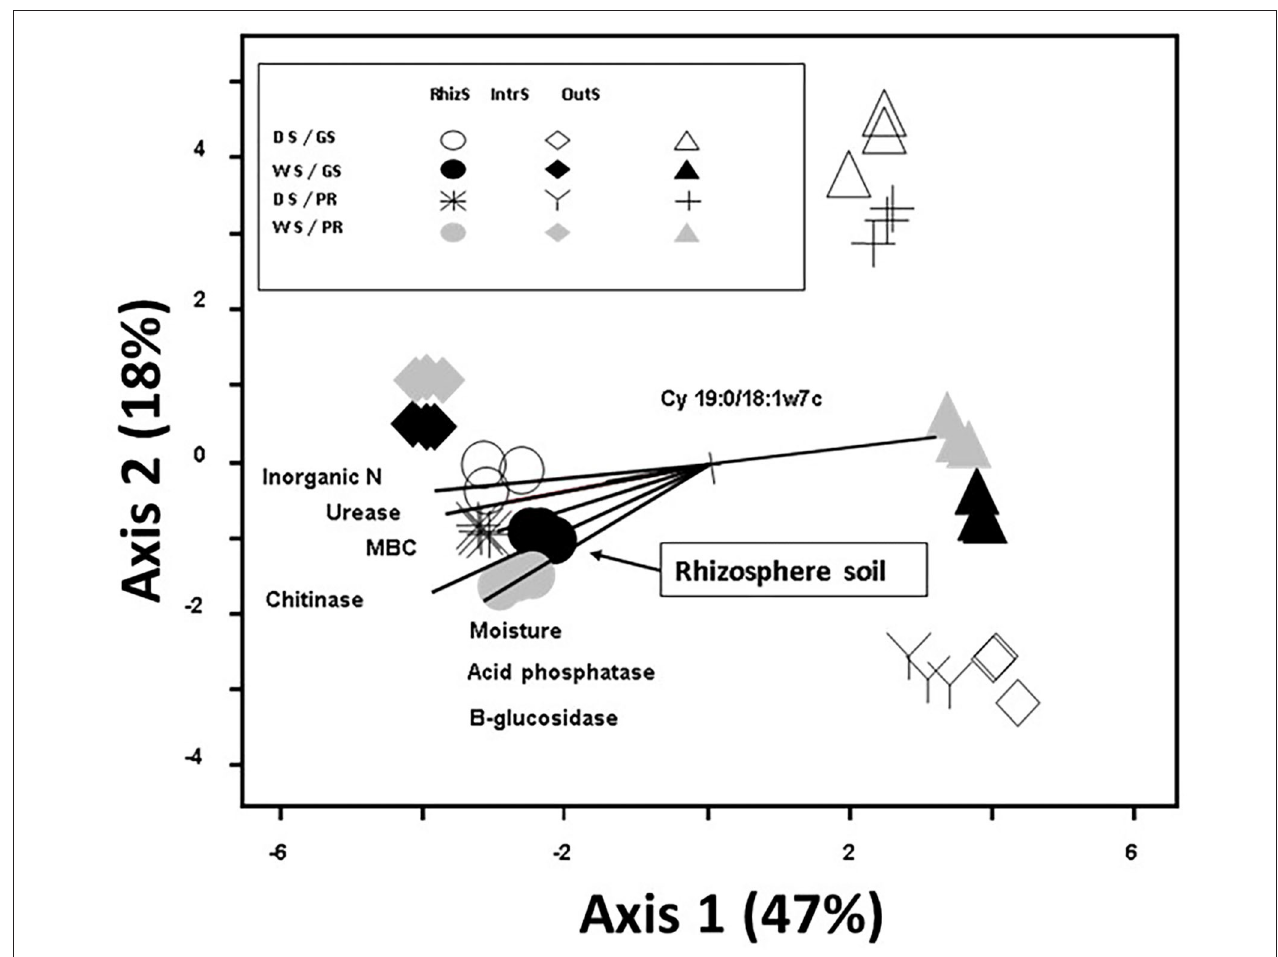
FIGURE 2 | Principle Component Analysis based on 23 phospholipid microbial markers from soil associated with G. senegalensis (GS) and P. reticulatum (PR) which are shrubs that co-exist with row crops in the Sahel. The vectors are joint plots of enzyme activities. Soil samples (RhizS, shrub rhizosphere soil; IntrS, inter-root soil; and OutS, outside the influence of shrub soil) are from the dry season (DS) and wet season